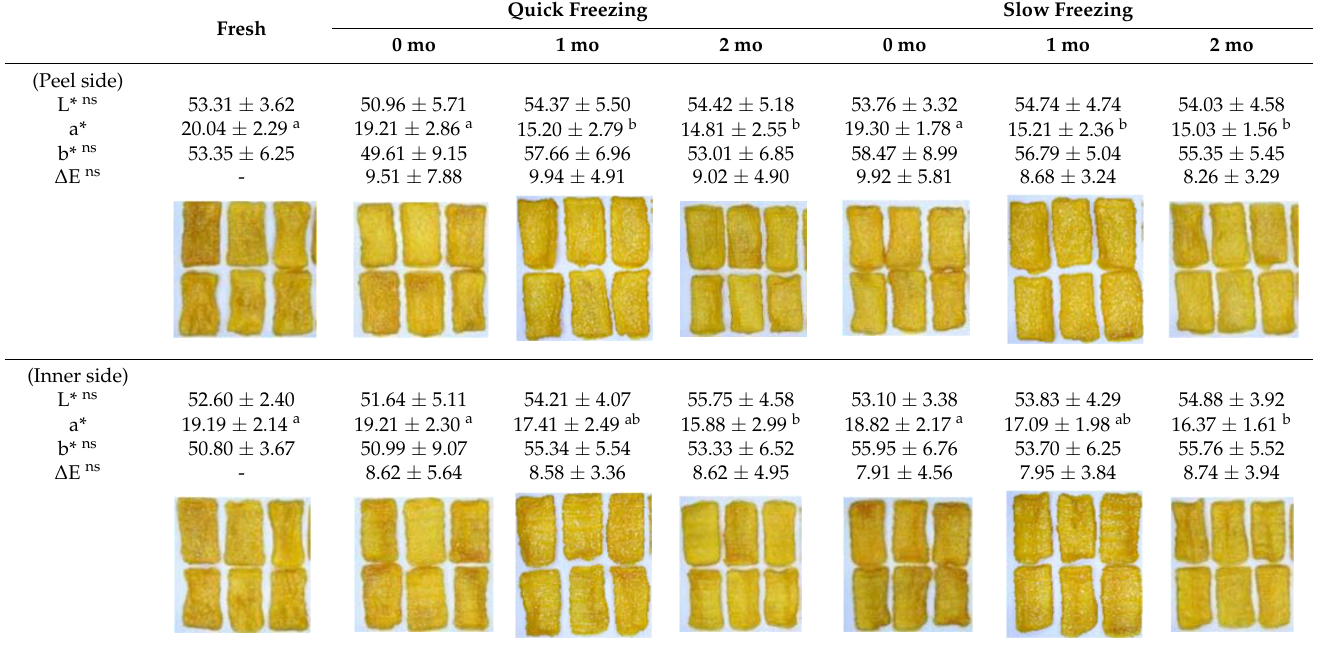
Table 4. Appearance and color parameters of osmotic hot air ‐ dried mango slabs. Fresh